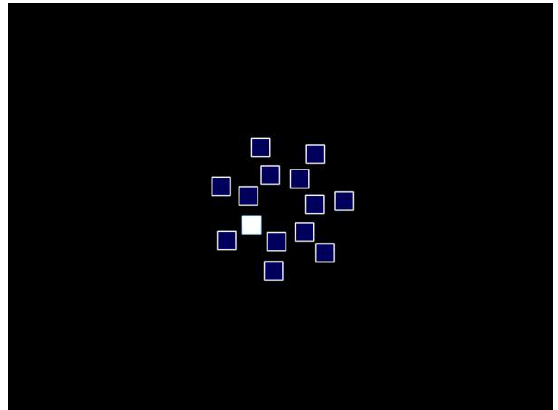
Figure 21. Screenshot showing target and distractors. Table 2. Details on pointing targets.